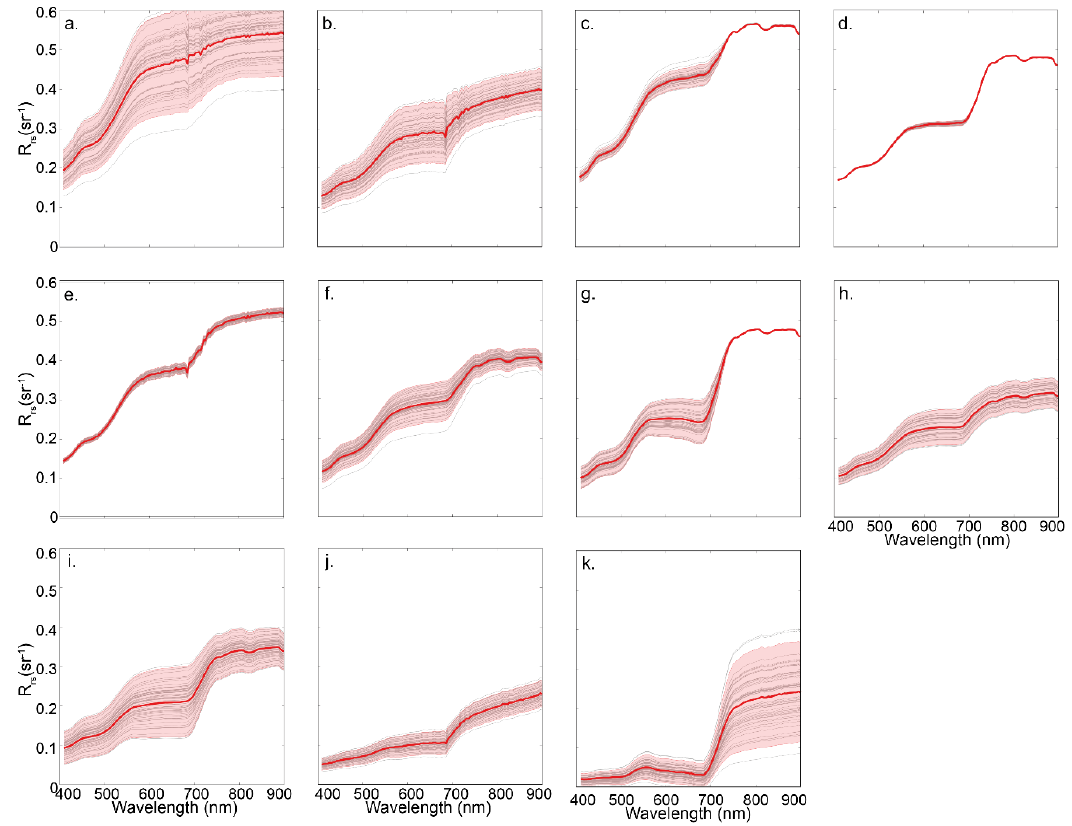
Figure 6. End-member spectra of 11 coastal dune ground cover classes generated from airborne hyperspectral data: ( a ) mobile dune sand (MDS), ( b ) grey dune sand (GDS), ( c ) Elymus farctus (Ely), ( d ) Otanthus maritimus (Ota), ( e ) sparse vegetation (SPV), ( f ) Ammophila arenaria (Amm), ( g ) Galium arenarium (Gal), ( h ) Helychrisum stoechas (Hel), ( i ) Artemisia campestris (Hel), ( j ) grey dune vegetation (GDV), and ( k ) Pinus marimima (Pin). Remote Sens. 2020 , 12 , x FOR PEER REVIEW 13 of 24